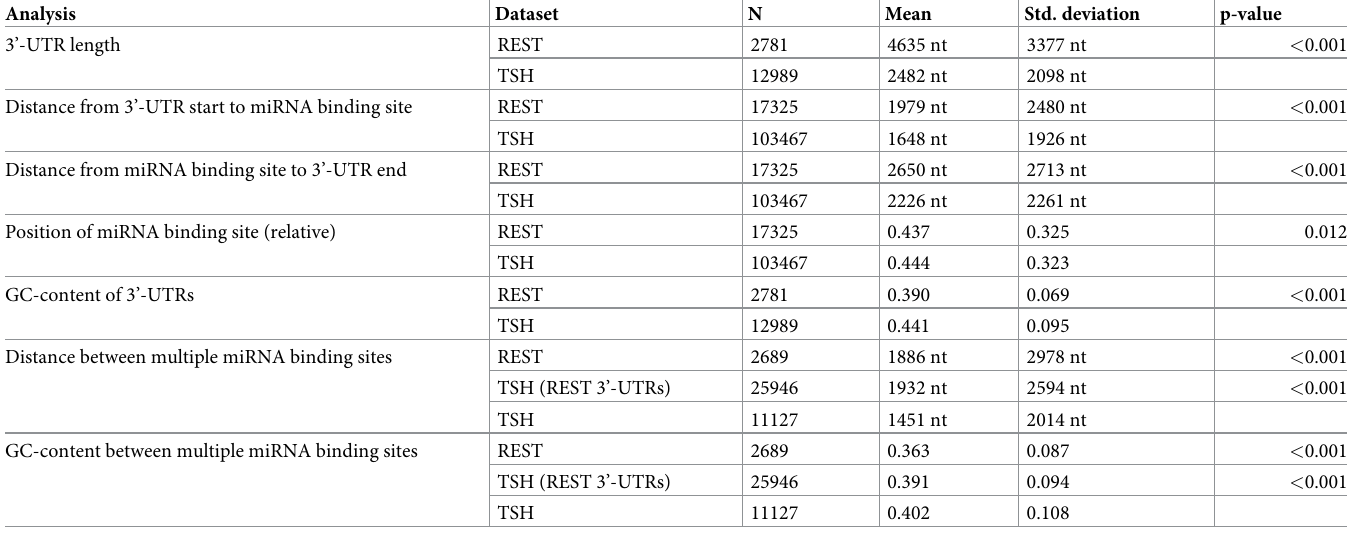
Table 1. Descriptive statistics and p-values for parsed properties of REST-associated miRNA-target gene pairs (REST) and TargetScanHuman miRNA-target gene pairs (TSH) or TargetScanHuman miRNA-target gene pairs in REST 3’-UTRs (TSH-REST) (see Materials and Methods for details).